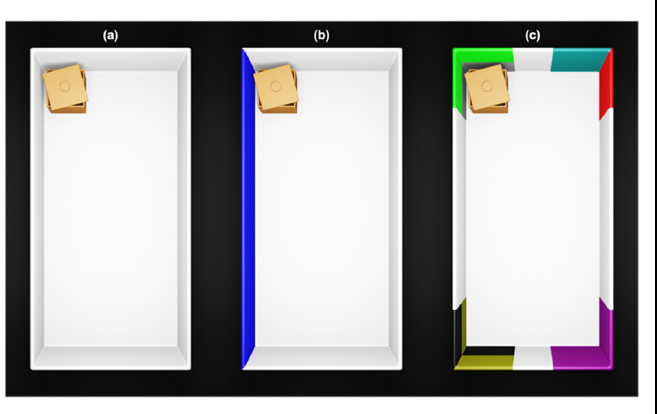
Figure 2. The geometric symmetry in ( a ) can be resolved by providing distinctive nongeometric cues. In ( b ), one of the two long surfaces has been painted in blue, and the correct corner can be identified by integrating the geometry with the landmark (i.e., the target corner has a long blue surface to its left). In ( c ), each corner has a distinctive pattern/color, and the local landmark itself is enough to identify the target (i.e., the corner with the box is lime ‐ gray patterned). Cheng [28] introduced two tests aimed at detecting how geometry and features could be combined to specify the rewarded locations: the “diagonal transposition”, in which the landmarks marking the rewarded diagonal were switched; the “affine transformation”, where each landmark was moved 90° right to put the features in conflict with geometry.